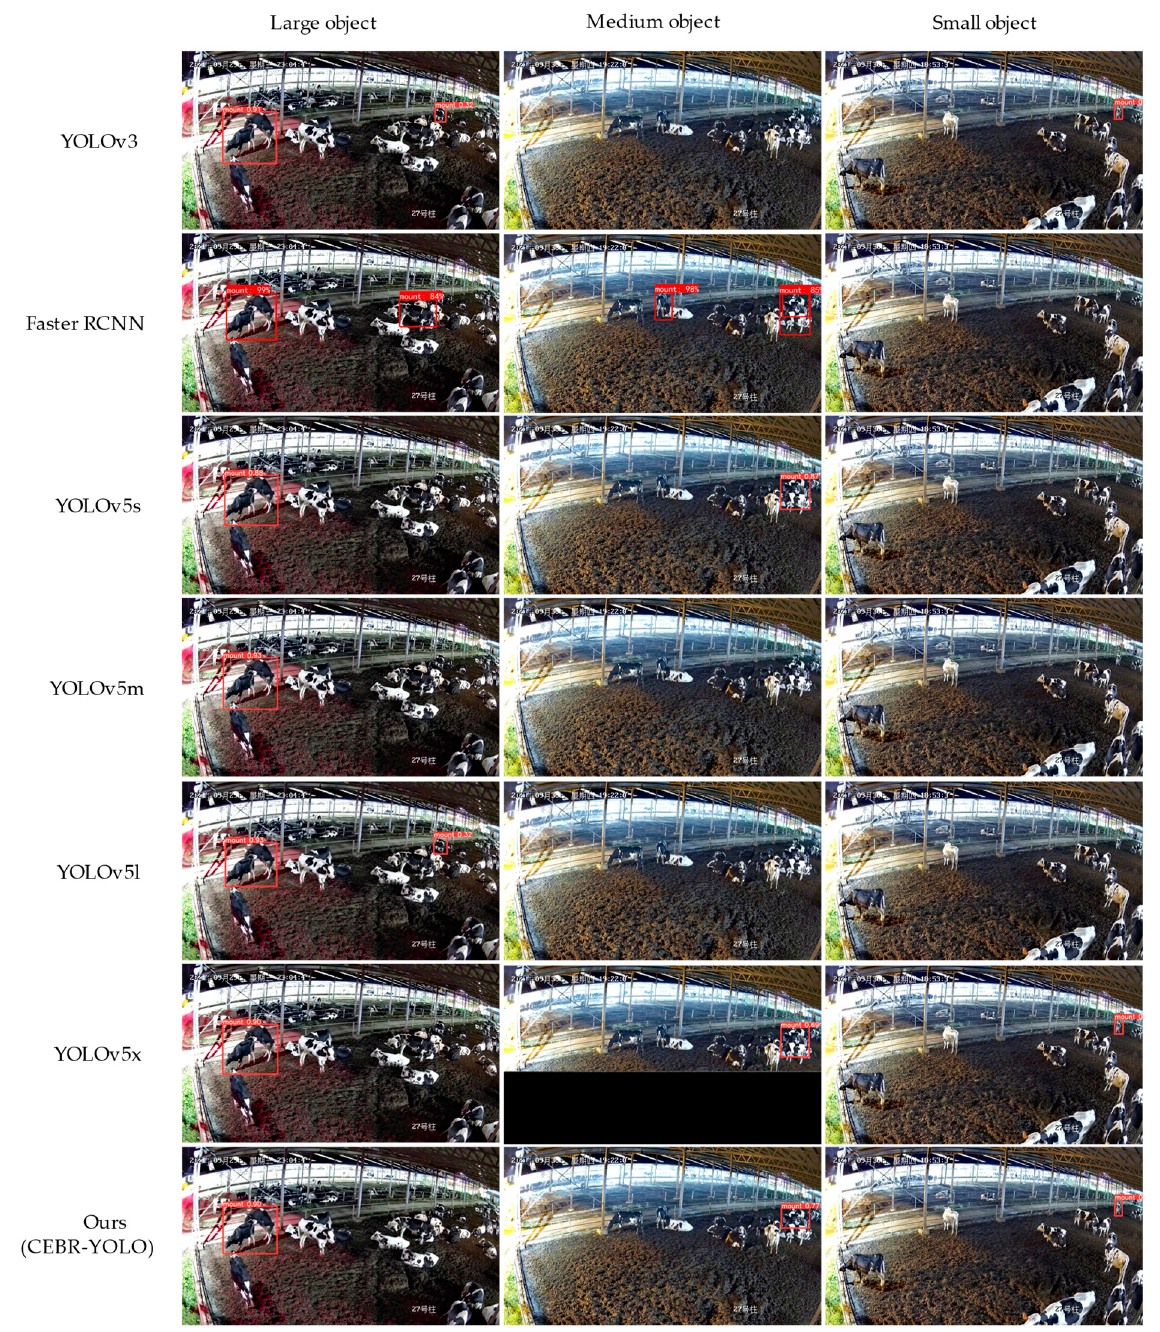
Figure 10. Visualization of the test results of different models.